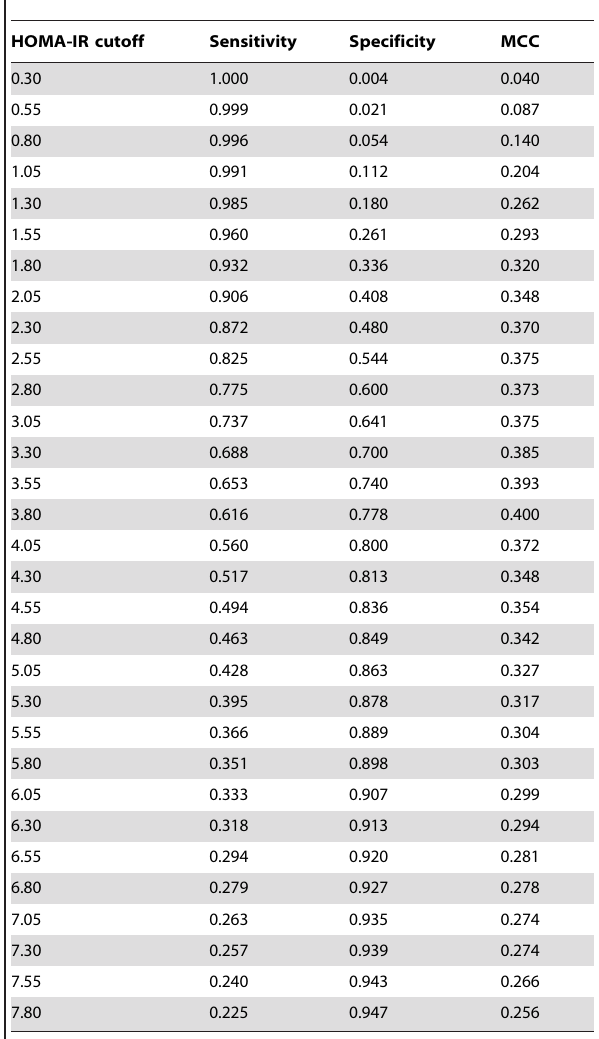
Table 2. The specificity and sensitivity for insulin resistance syndrome of various HOMA-IR cutoff values.